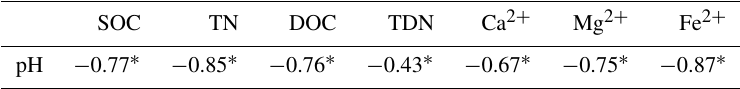
Table 2. Relationships between soil pH and soil organic carbon (SOC), total nitrogen (TN), dissolved organic carbon (DOC), total dissolved